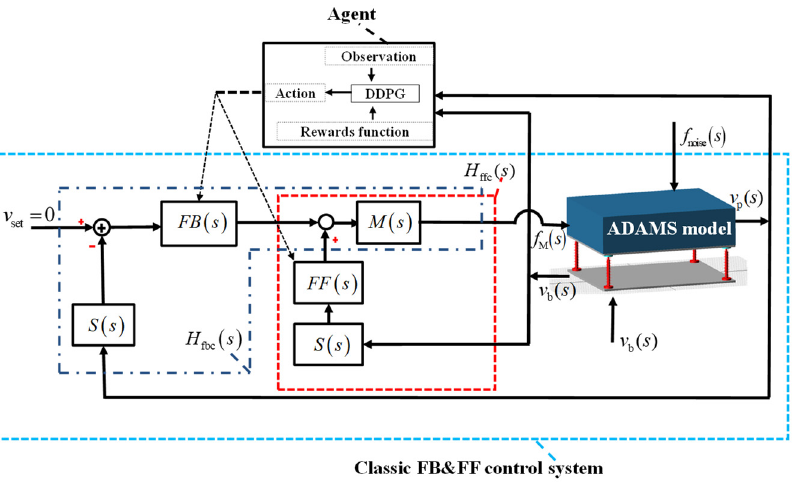
Figure 5. The principle of DDPG algorithm application in co-simulation.